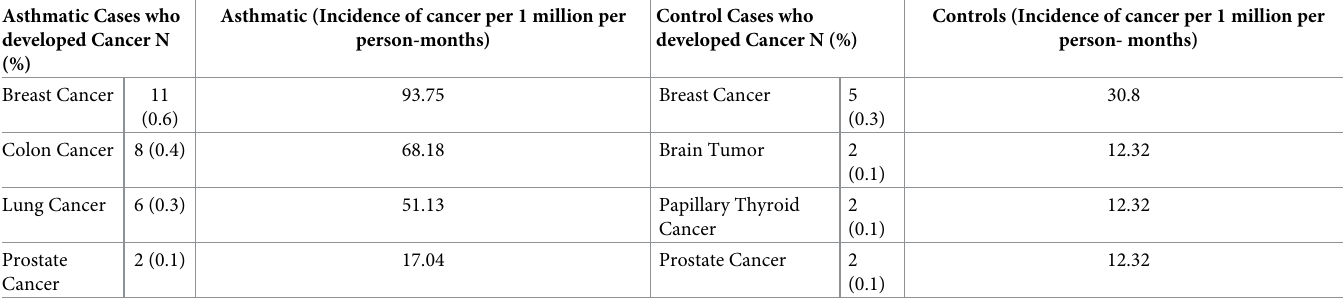
Table 2. Number and incidence of cancer per 1 million person-months among asthmatic cohort compared to controls.